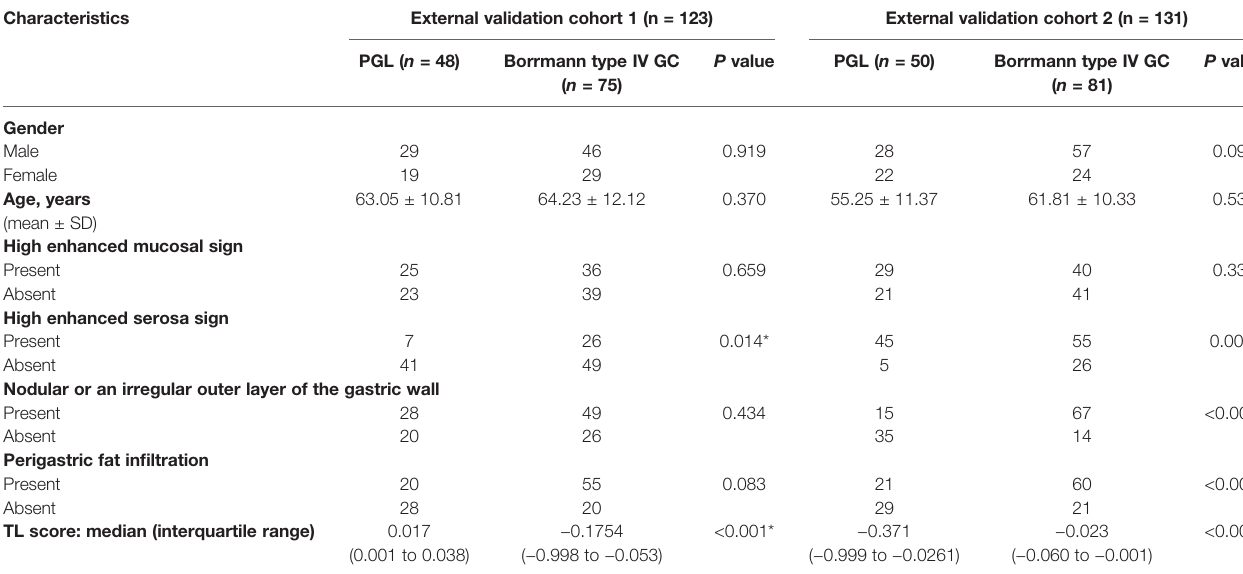
TABLE 1-2 | Clinical characteristics of PGL and Borrmann type IV GC patients in the external validation cohorts 1 and 2.